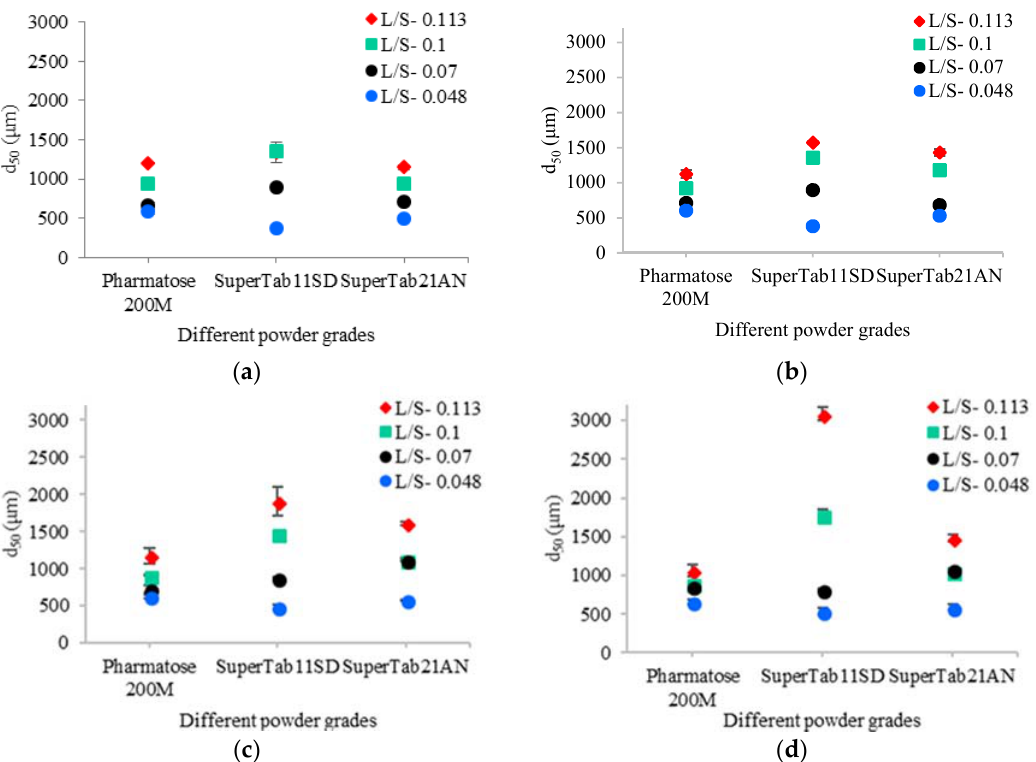
Figure 5. Median size of granules for different grades of lactose powder at varying L/S and screw speeds. ( a ) 200 rpm; ( b ) 450 rpm; ( c ) 700 rpm; ( d ) 950 rpm.